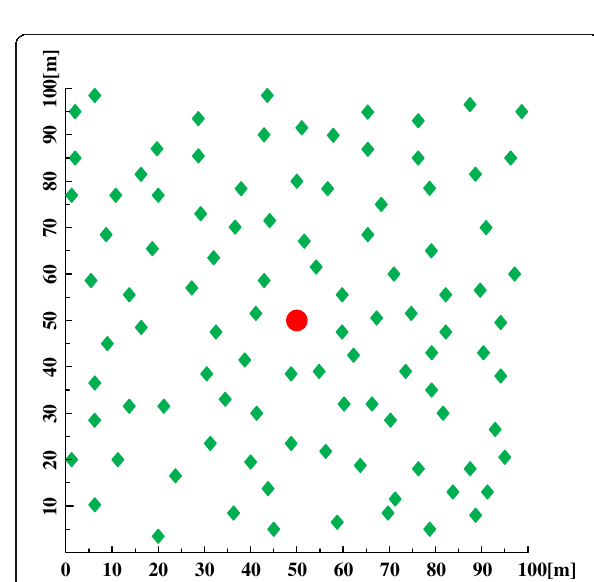
Fig. 6 100 nodes random ZigBee network. This figure shows that 100 nodes are placed in an observation area of 100 m × 100 m to collect information. Nodes are randomly distributed in the observation area, and the information of each node is managed by the